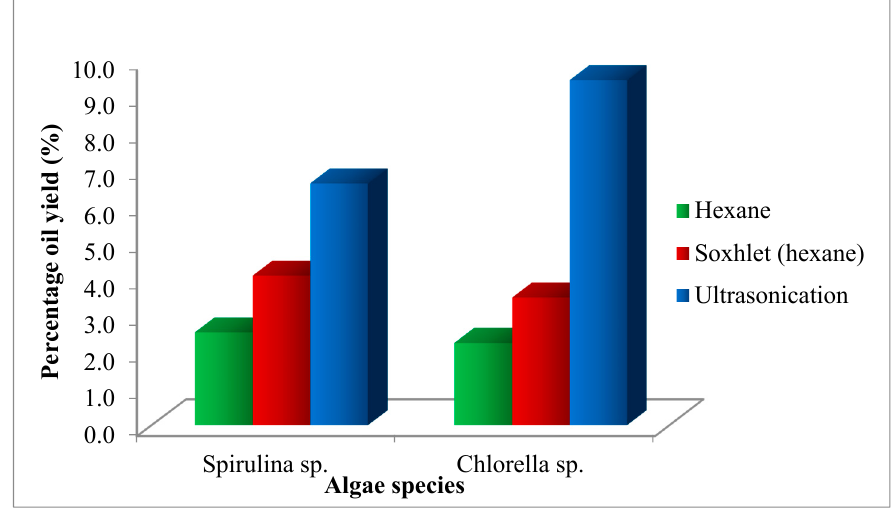
Figure 4. Percentage of oil yield for different extraction processes. Table 1. Comparison study of the percentage oil yield based on di ff erent extraction methods.